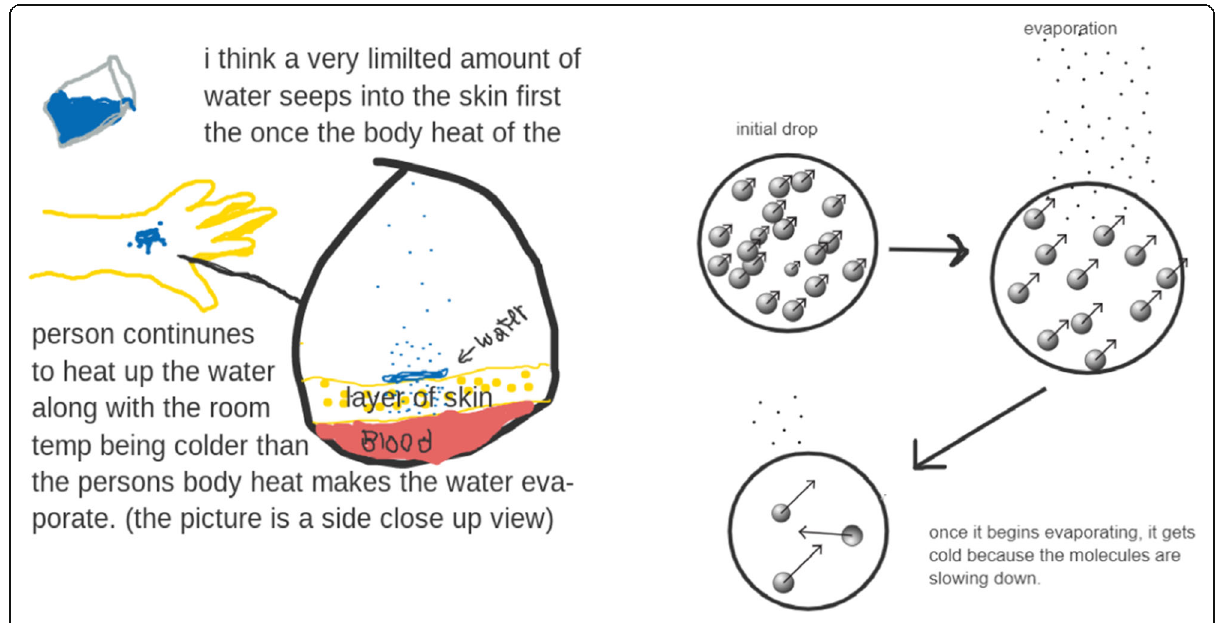
Fig. 5 Students ’ mechanistic modeling